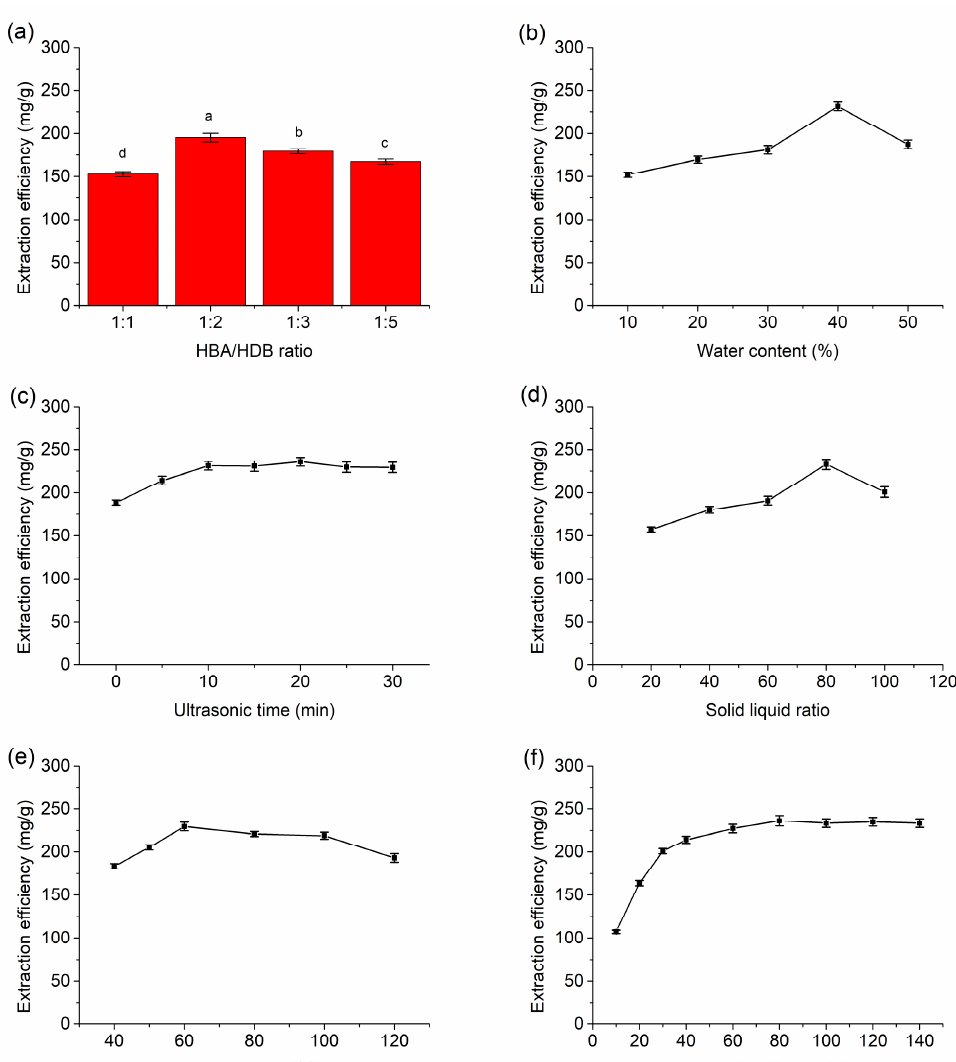
Figure 1. Optimization of extraction parameters in the UAE-DES method. ( a ) Effect of the HBA/HBD ratio on extraction efficiency; ( b ) effect of water content on extraction efficiency; ( c ) effect of ultrasonic time on extraction efficiency; ( d ) effect of the solid–liquid ratio on extraction efficiency; ( e ) effect of temperature on extraction efficiency; ( f ) effect of extraction time on extraction efficiency. Values followed by different letters (a–d) are significantly different according to Duncan’s test ( p < 0.05).